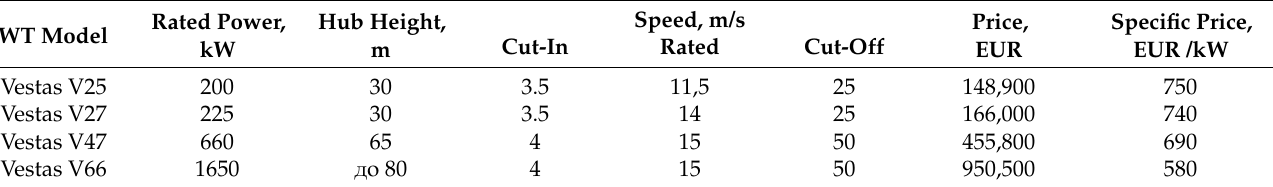
Table 2. Main characteristics of